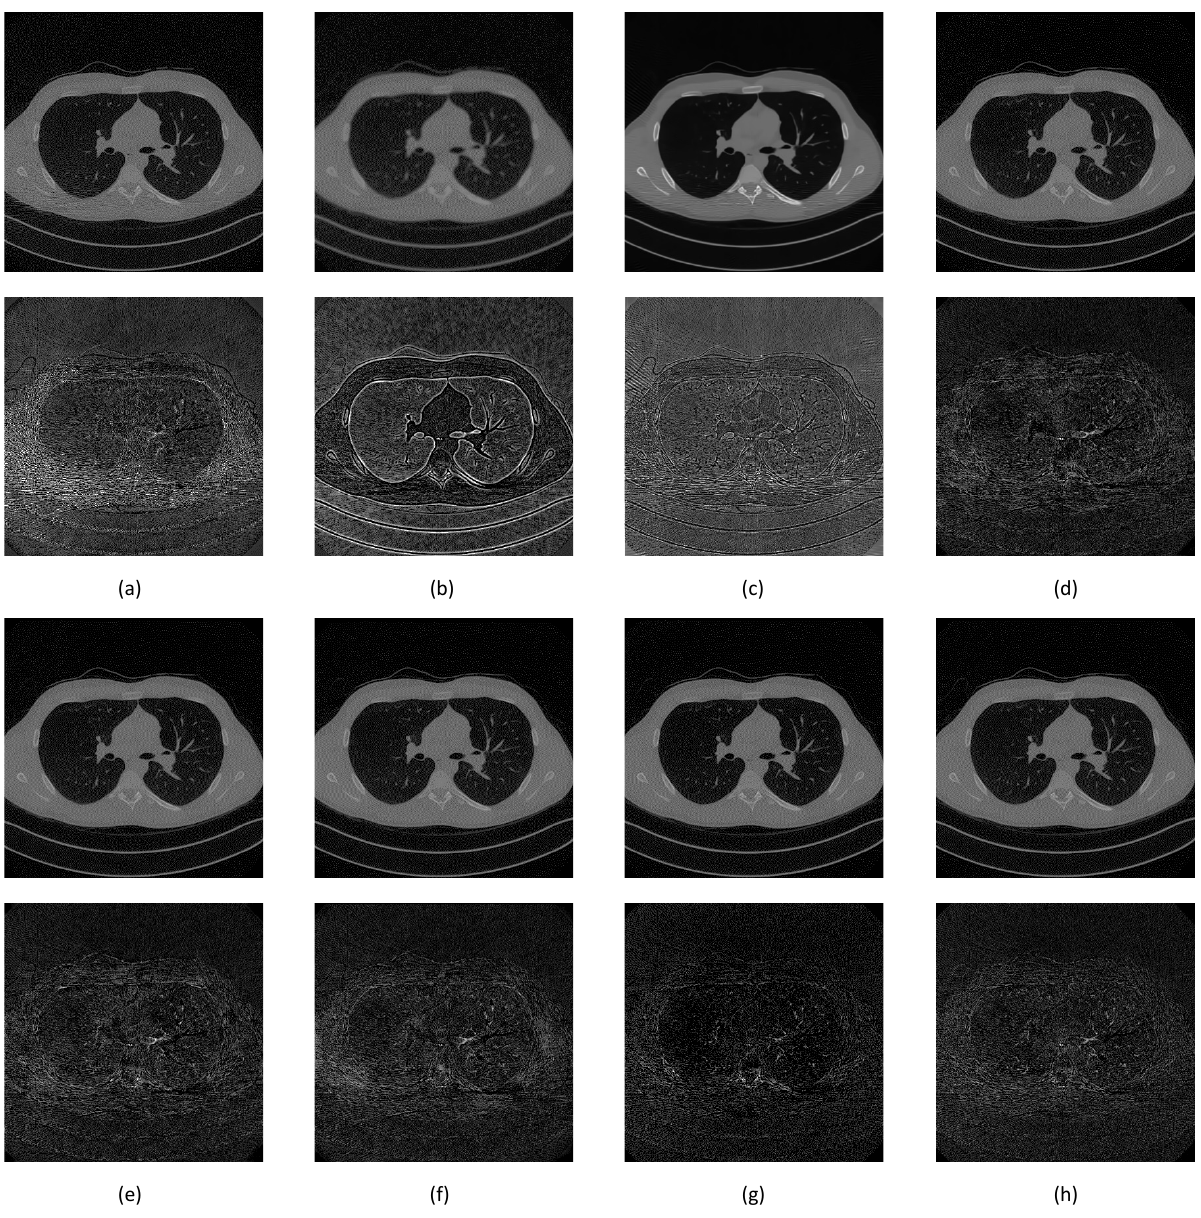
Figure 13. Image comparison between denoising methods in the middle lung area. The first row is the denoising result while the second row is the noise mask. ( a ) NLM, 59.7933 dB; ( b ) Gaussian, 55.5066 dB; ( c ) BM3D, 59.8350 dB; ( d ) SegNet, 61.3051 dB; ( e ) DeConvNet, 61.3086 dB; ( f ) RedNet, 61.6290 dB; ( g ) U-Net, 61.6312 dB; and ( h ) S-Dual 3, 62.0255